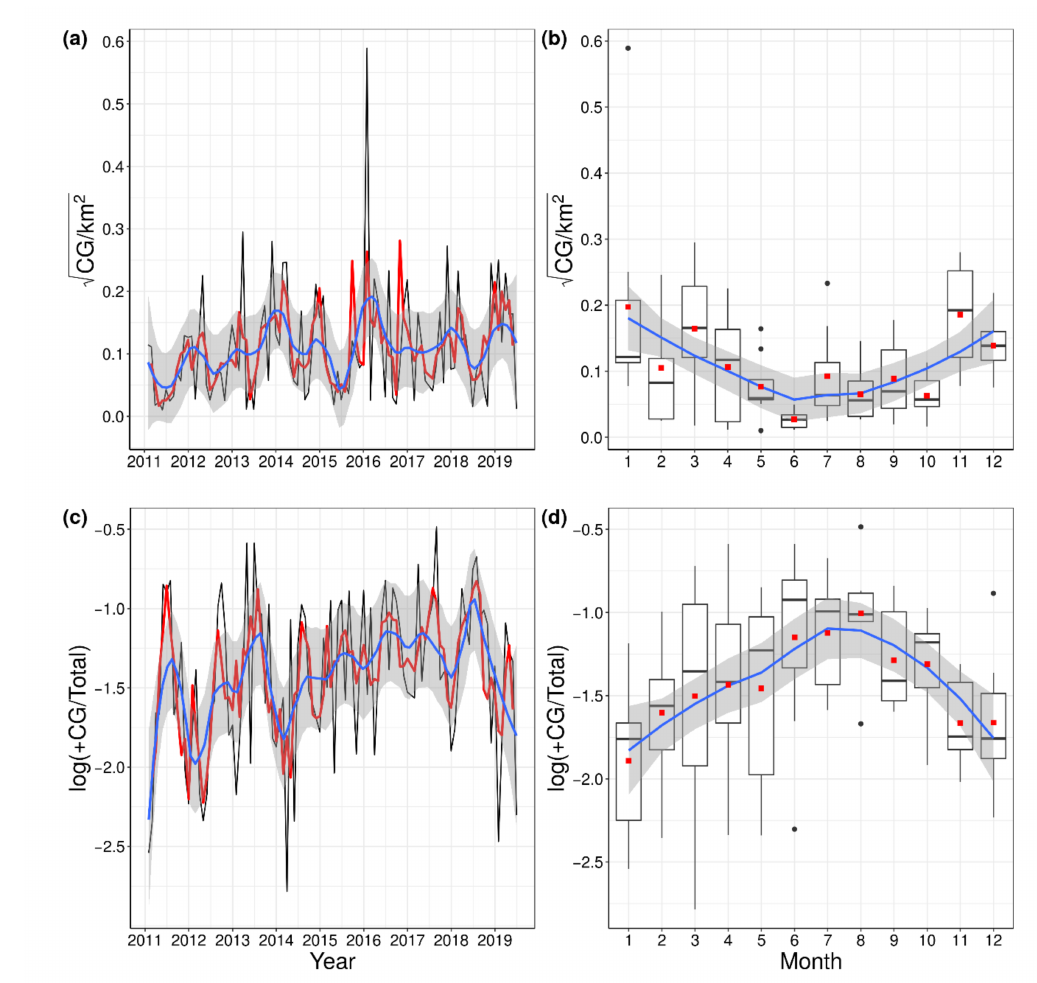
Figure 3. Plots ( a ) monthly time series and ( b ) monthly boxplot show square root of the rate of cloud-to-ground (CG) lightning strikes per square kilometer. Plots ( c ) monthly time series and ( d ) monthly boxplot show logarithmic function of the ratio of positive strokes from the total number of lightning strikes. Each plot also includes a smoother loess (blue line) and the respective confidence intervals (grey area). A three-month moving average (red line) in plots ( a ) and ( c ) compares the periodic seasonal component. The outliers (black dots) are associated with storms resulting from infrequent weather phenomena. The mean value (red points) of each boxplot